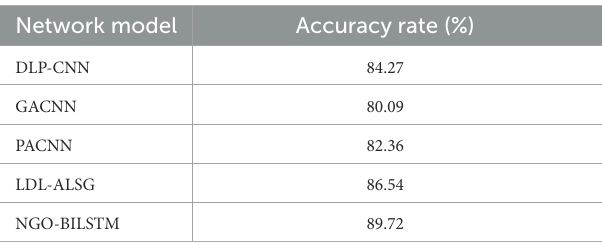
TABLE 7 Accuracy of different models on the RAF-DB